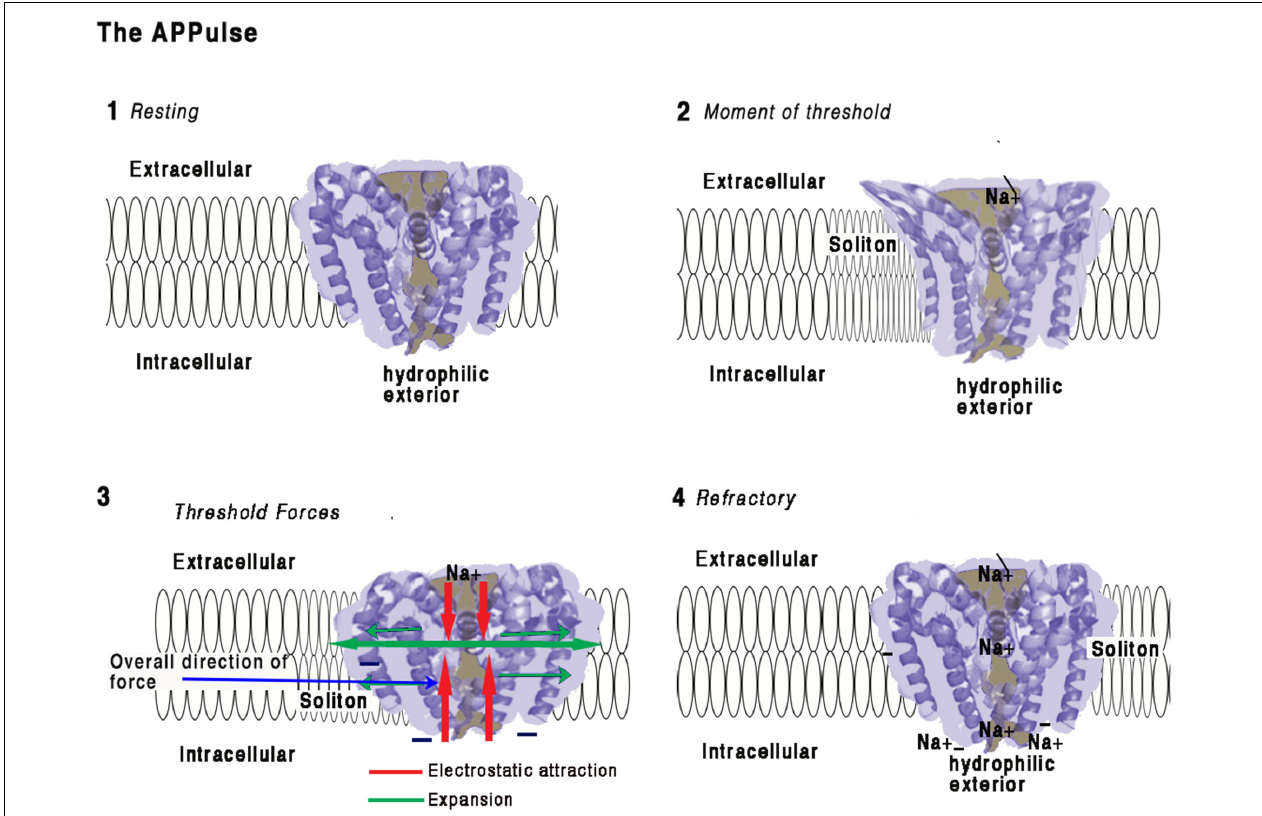
FIGURE 2 | Illustration of how force from lipid may act on a eukaryotic voltage-gated sodium ion channel from the American cockroach (adapted from McCusker et al., 2012 and Shen et al., 2017). (1) Resting: Ion channel embedded in a membrane at resting state. The main structure of a channel is four coiled helices. One of these helices is connected to a